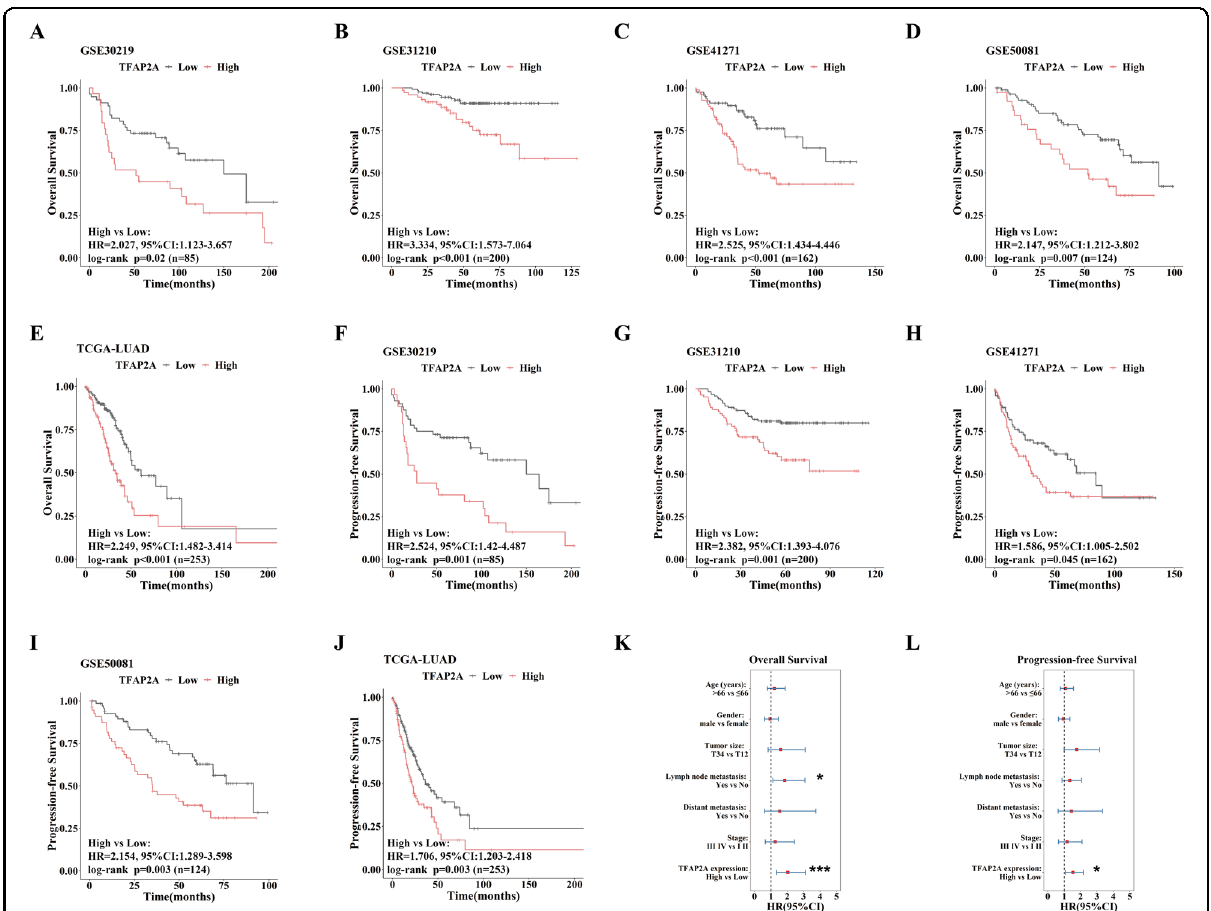
Fig. 2 High expression of TFAP2A in LUAD predicts poor clinical prognosis. A – E OS curves between LUAD patients with high or low TFAP2A expression and HRs of univariate analysis (high group vs. low group) in fi ve independent LUAD datasets (GSE30129, GSE31210, GSE41271, GSE50081 and TCGA-LUAD). F – J PFS curves between LUAD patients with high or low TFAP2A expression and HRs of univariate analysis (high group vs. low group) in fi ve independent LUAD datasets (GSE30129, GSE31210, GSE41271, GSE50081 and TCGA-LUAD). K , L HRs of multivariate analysis (age, gender, TNM, clinical stage and TFAP2A expression) towards OS and PFS in TCGA-LUAD datasets. * p < 0.05; ** p < 0.01; *** p <